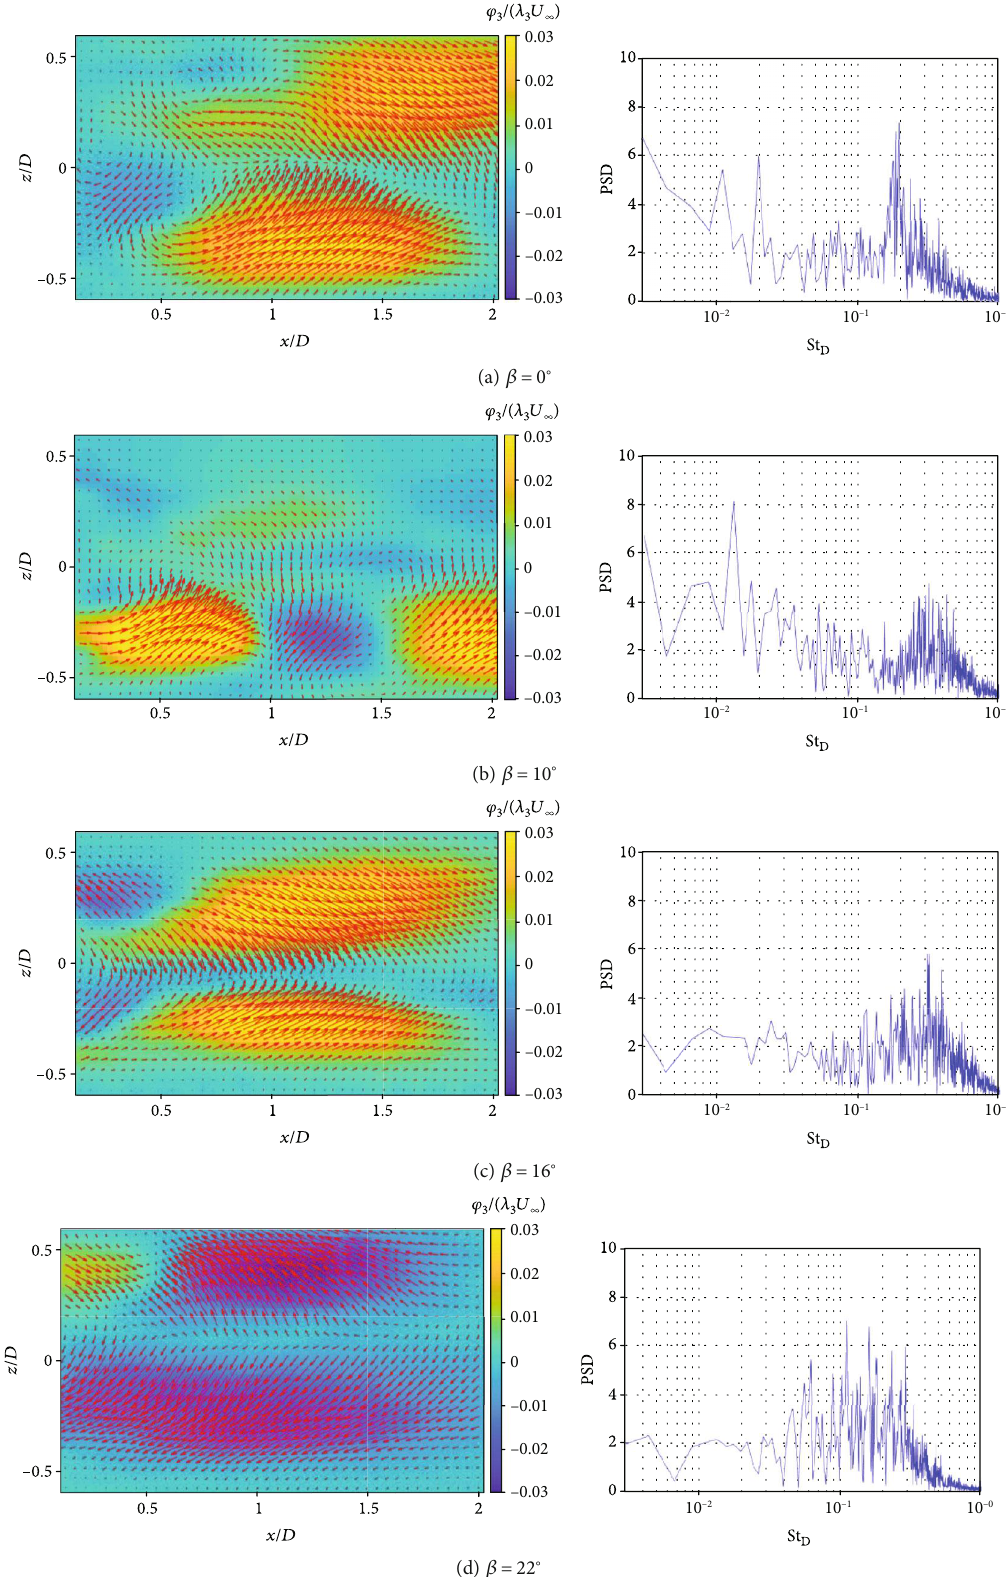
Figure 18: Spatial distribution of the third POD mode at (a) β = 0 ° , (b) β = 10 ° , (c) β = 16 ° , and (d) β = 22 °